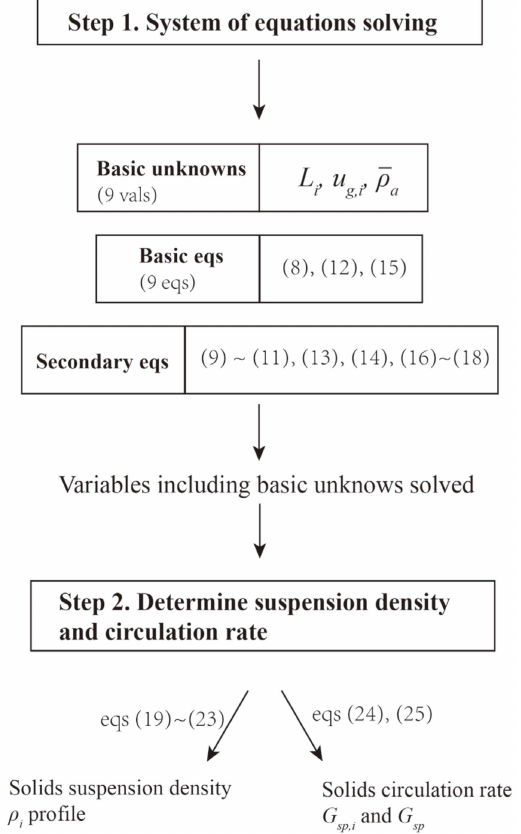
Figure 6. Solution procedure of theoretical